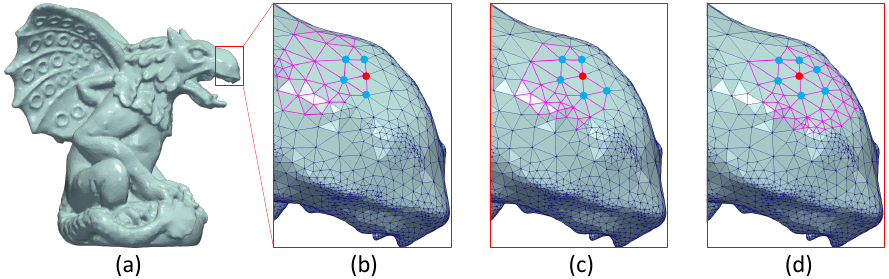
Figure 2. The red point has different degree in each submesh of the ( a ) original model (Gargoyle model), the corresponding weights are: ( b ) w = 4, ( c ) w = 5, ( d ) w =